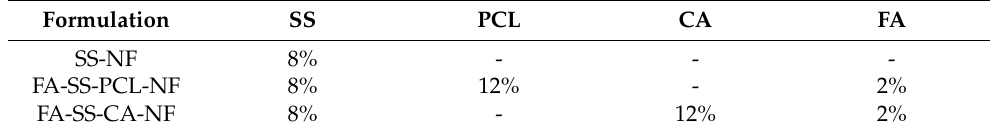
Table 1. Optimized concentrationof polymers and drug solution for electrospinning. Formulation SS PCL CA FA SS-NF 8% - - - FA-SS-PCL-NF 8% 12% - 2% FA-SS-CA-NF 8% - 12%